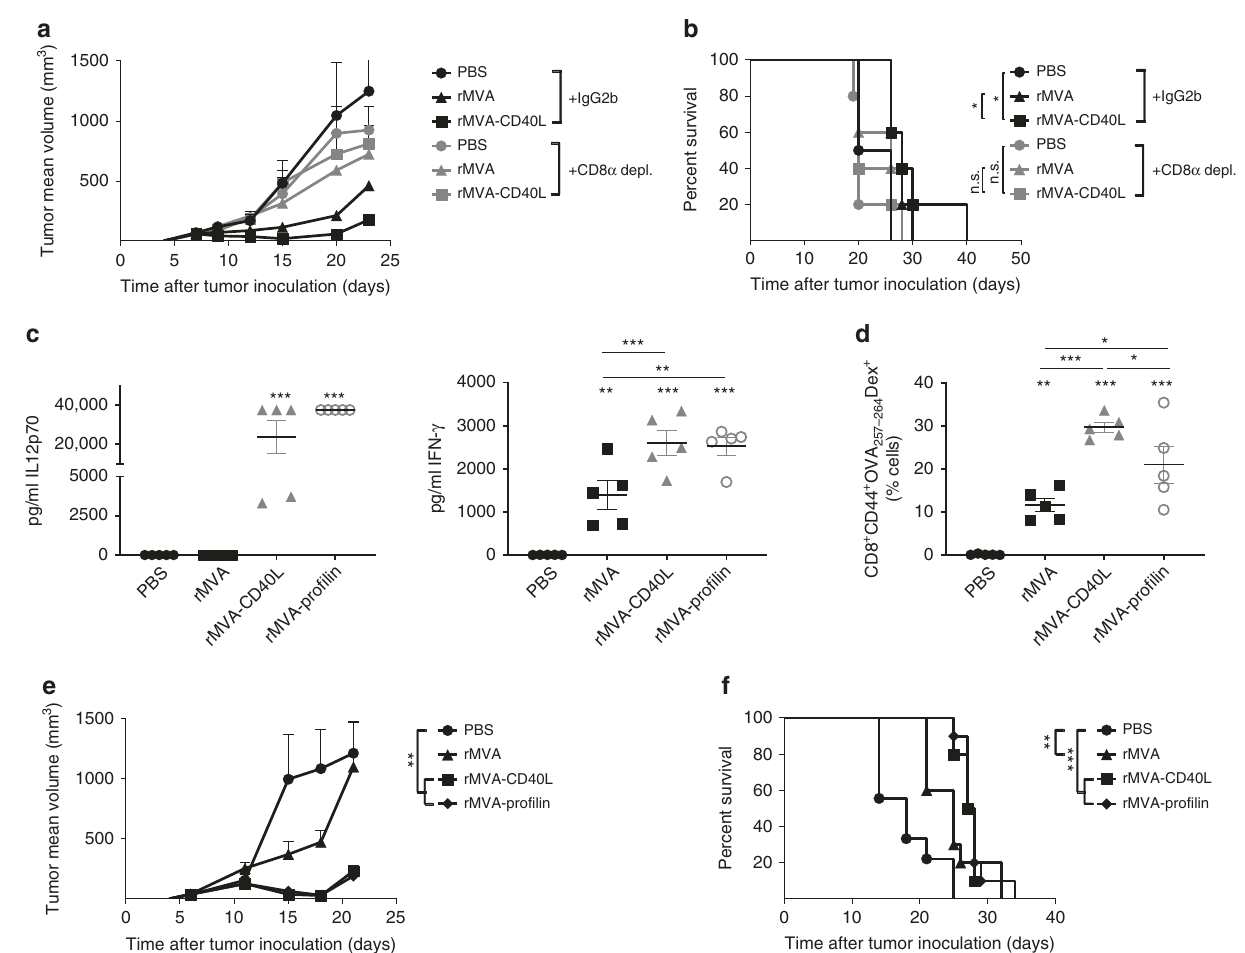
Fig. 3 Role of CD8 + T cells during rMVA-CD40L-induced tumor growth control. a , b CD8 depletion in B16.OVA tumor-bearing mice. When B16.OVA tumors were above 50 mm 3 , mice received PBS or were immunized with 5 × 10 7 TCID 50 of either rMVA or rMVA-CD40L. Where indicated, mice